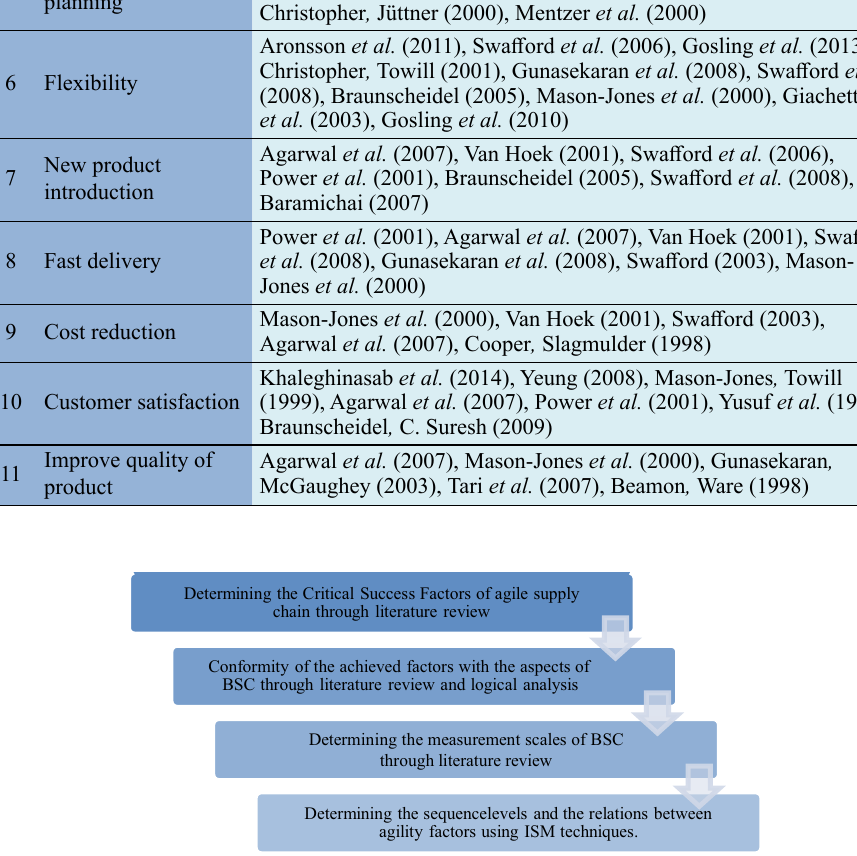
Fig. 1. Process of developing an agile supply chain